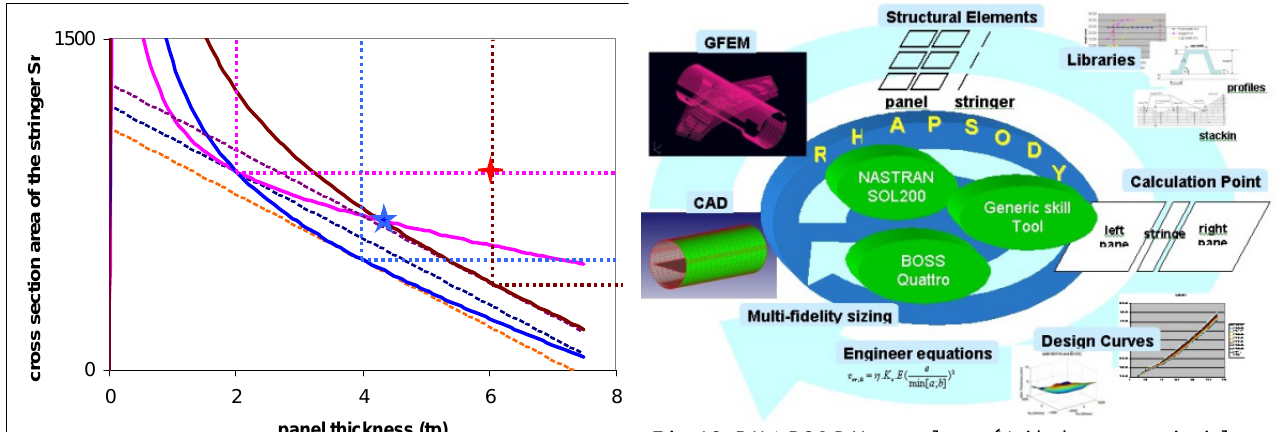
Fig. 18: RHAPSODY at a glance (With the same principles Fig. 16. Approximation of feasibility domain yielded by design curve